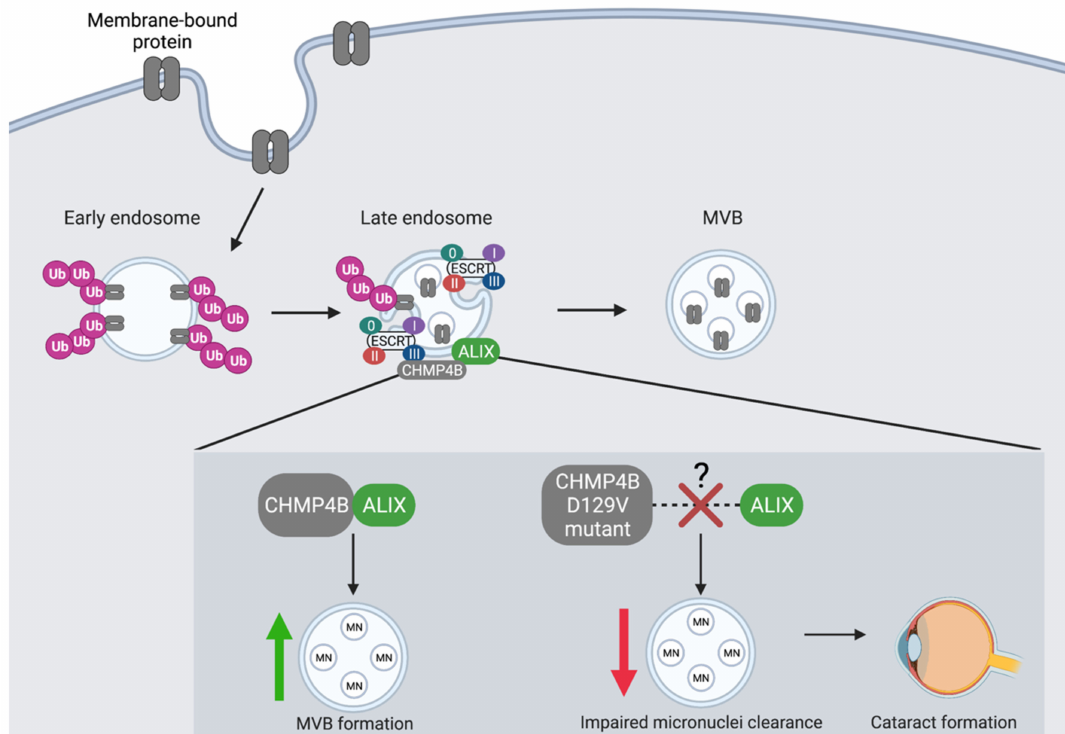
Figure 3. The co-localization of CHMP4B and ALIX is an essential regulatory event in the autophagic degradation of micronuclei. CHMP4 proteins are essential components of the MVB pathway where they interact with ESCRT-III to recruit the ALG-2 interacting protein (ALIX). CHMP4B shows the greatest binding affinity towards ALIX. CHMP4B plays an essential role in the recycling of micronuclei (MN), which is dependent upon its recruitment and interaction with ALIX at the endosome. CHMP4B localizes to micronuclei in the lens of the eye to facilitate autophagic degradation and prevent cataract formation. The D129V mutation in CHMP4B is linked to cataract formation likely as a result of a blocked interaction between CHMP4B and ALIX, which leads to decreased autophagic degradation of MVB cargo and accumulation of